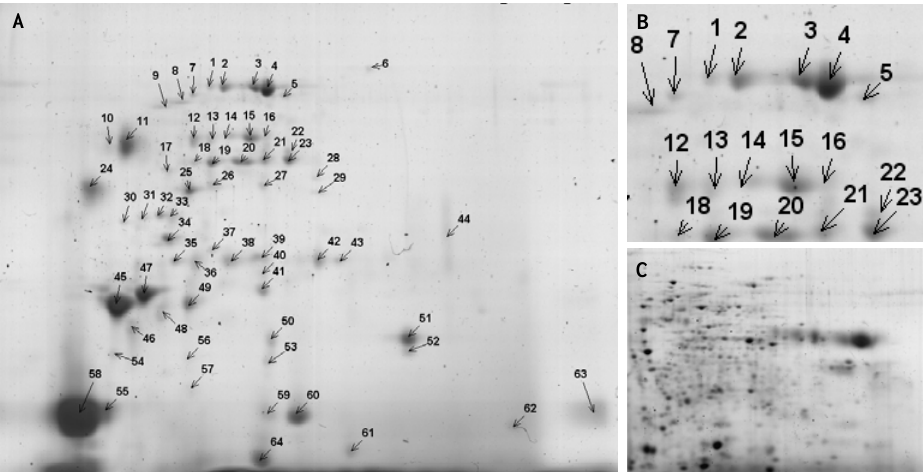
Figure 2. Protein separation by two-dimensional gel electrophoresis